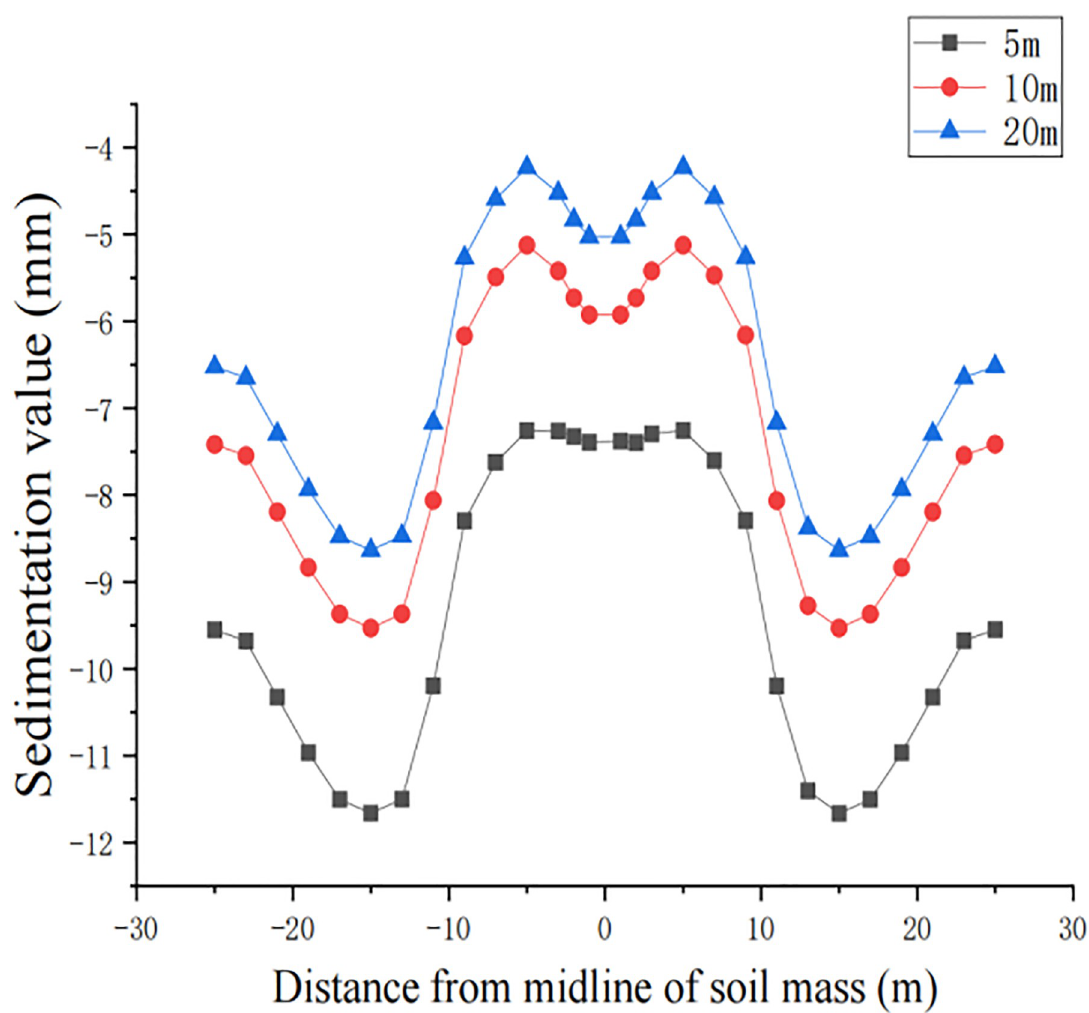
Fig 17. Surface deformation curves for three working conditions of pulverized